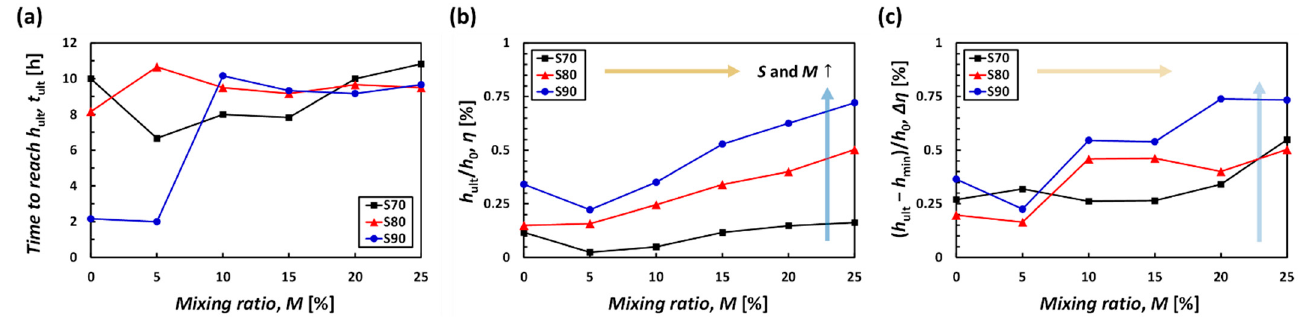
Figure 6. Summary of frost heaving tests. ( a ) Time to reach ultimate frost heaving ( t ult ), ( b ) heaving ratio ( η ), and ( c ) total heaving ratio ( Δ η ) with respect to mixing ratio.